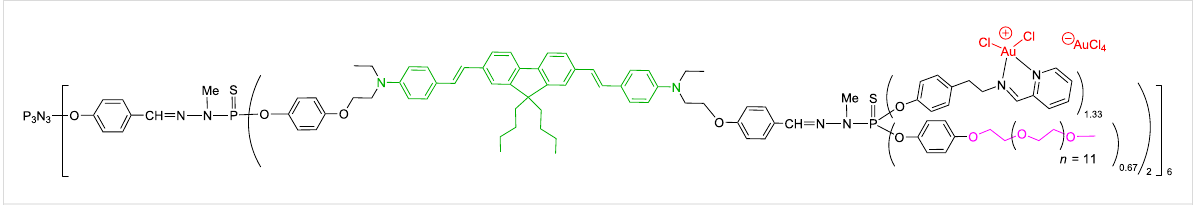
Figure 10: Fluorescent gold complex having high antiproliferative activities against different tumor cell lines.